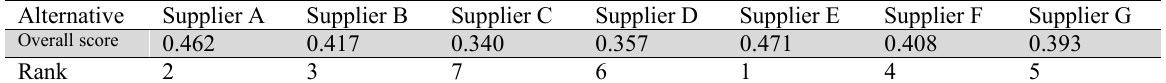
Overall score and ranking of each Alternative in the nominal problem of example 4 Alternative